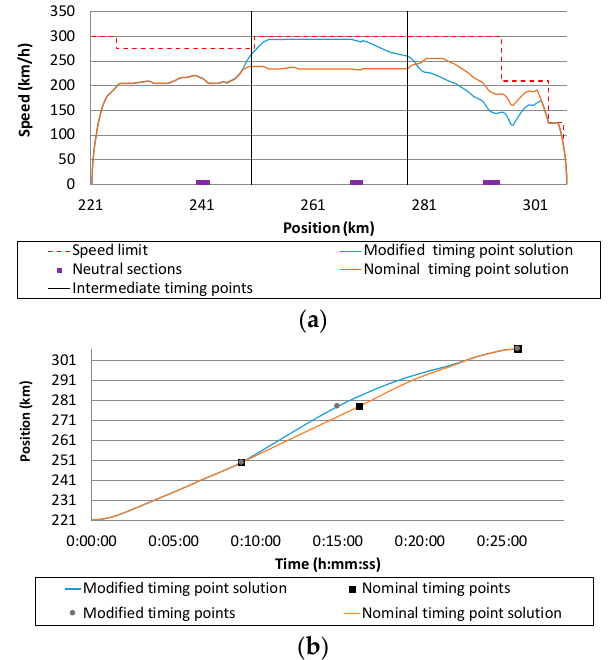
Figure 14. Speed profile ( a ) and position evolution with time ( b ) of the solution found by the algorithm for the case of two intermediate timing points with modifications respect to the timetable.